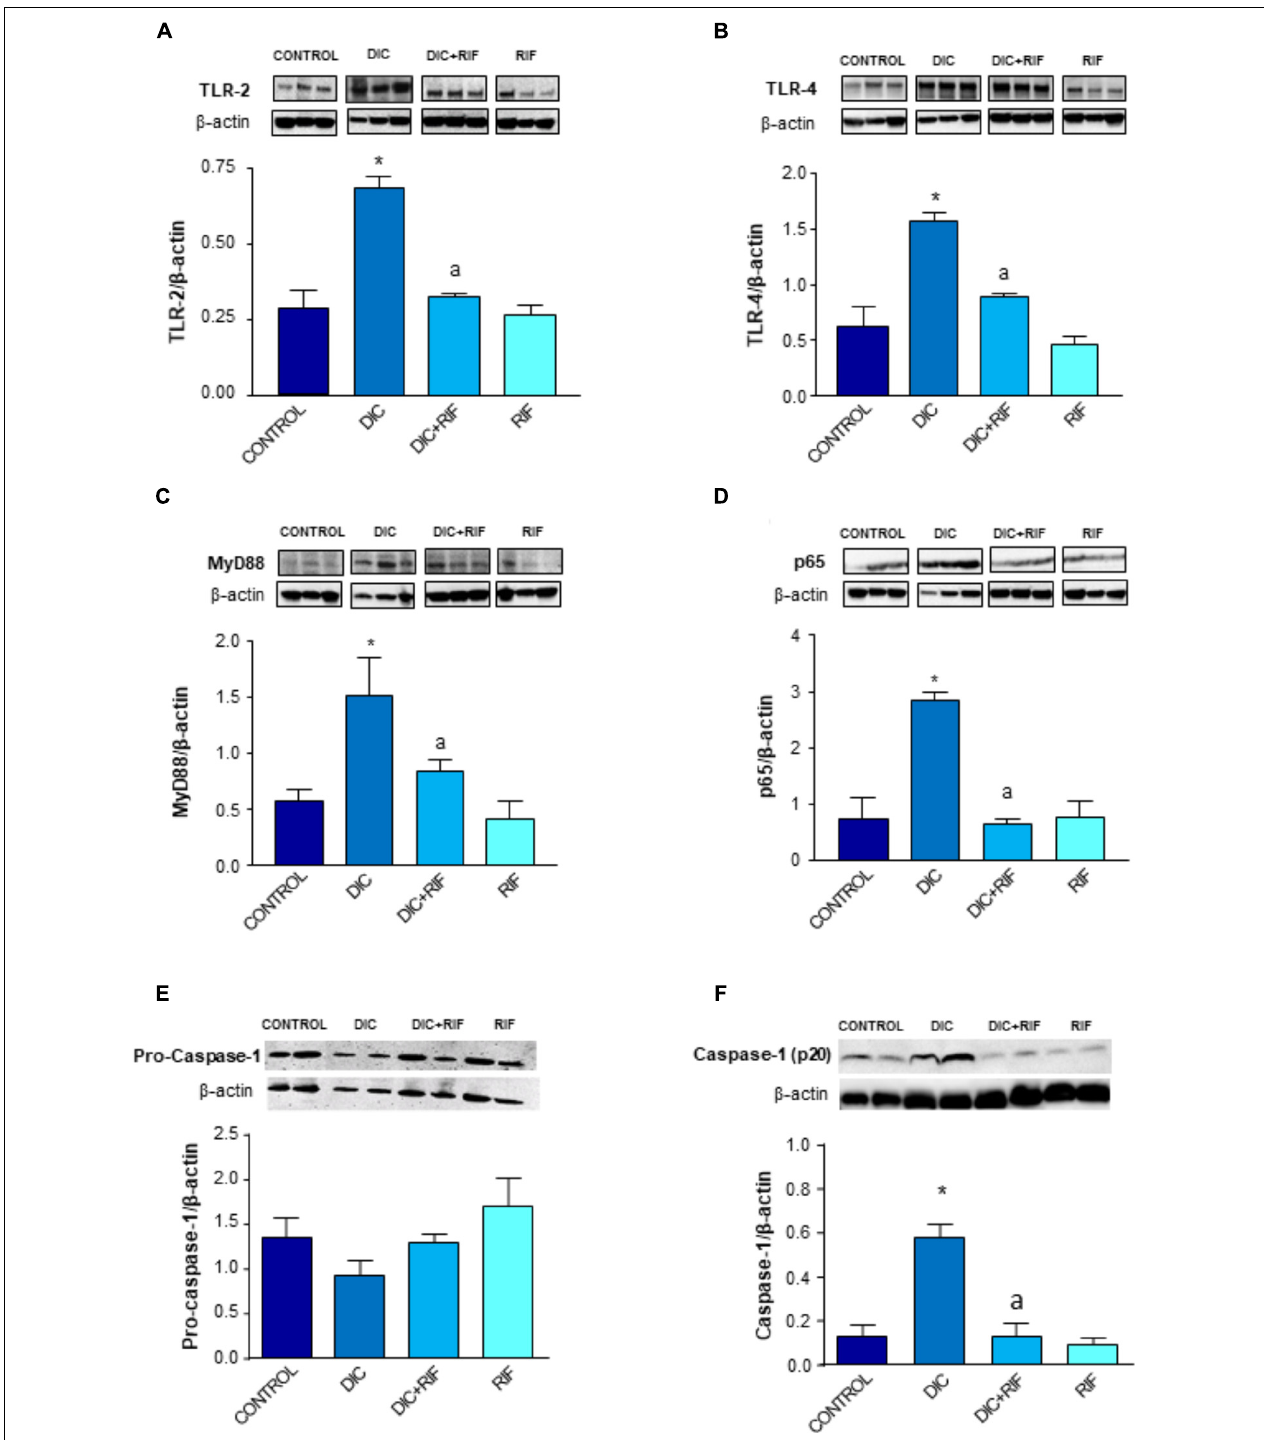
FIGURE 4 | Western blot analysis of toll-like receptor-2 (TLR-2) (A) , toll-like receptor-4 (TLR-4) (B) , myeloid-differentiation primary response gene 88 (MyD88) (C) , activated nuclear factor- κ B (p65) (D) , pro-caspase-1 (E), and caspase-1 (p20) (F) in the ileum of rats treated with vehicle (Control), diclofenac (DIC, 4 mg/kg BID), diclofenac plus rifaximin (DIC+RIF, 50 mg/kg BID), or rifaximin (RIF) for 14 days. Each column represents the mean ± SEM obtained from 10 animals. ∗ p < 0.05, significant difference versus Control; a p < 0.05, significant difference versus diclofenac alone. Note that the beta actin signals in (A,D) result from stripping and re-probing the same membrane, where TLR-2- and p65 proteins have been detected.